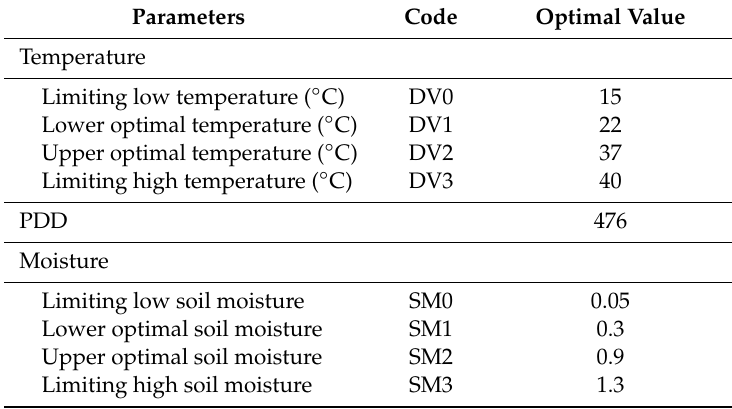
Table 1. Optimal values for CLIMEX parameters for red imported fire